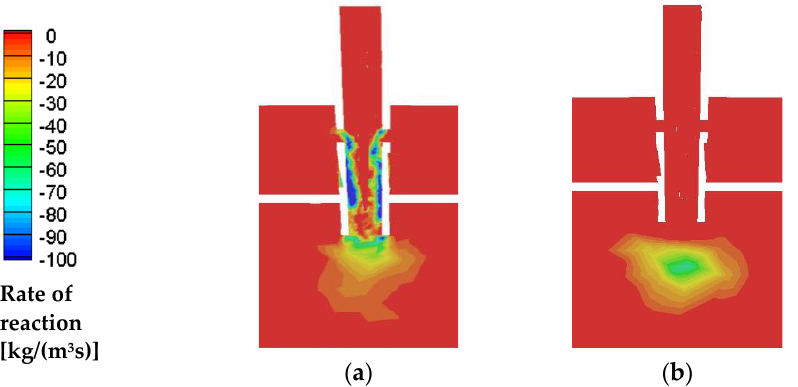
Figure 6. Hydrogen reaction rates when injected from premix ( a ) and from pilot ( b ) lines [36].